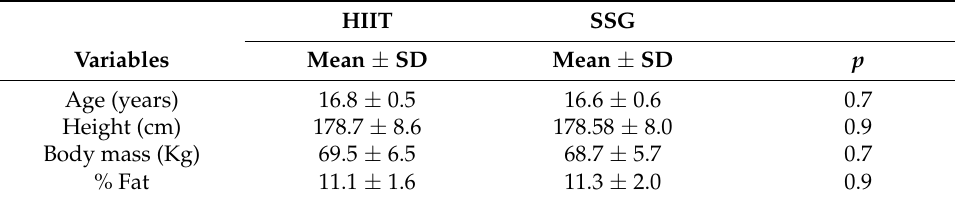
Table 1. The characteristics of the subjects in HIIT and SSG group (means ±